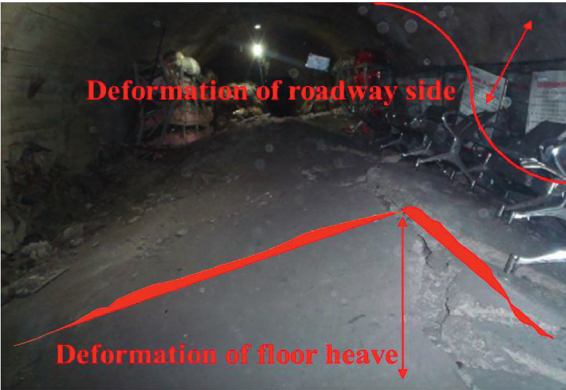
Figure 1: Deformation and failure of the roadway.